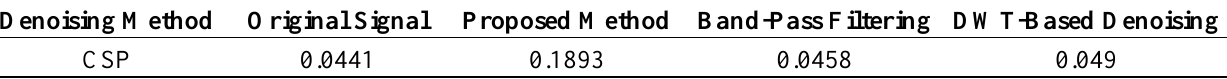
Table 4. The CSP values for the denoising results of different methods for rolling-element defective signal.